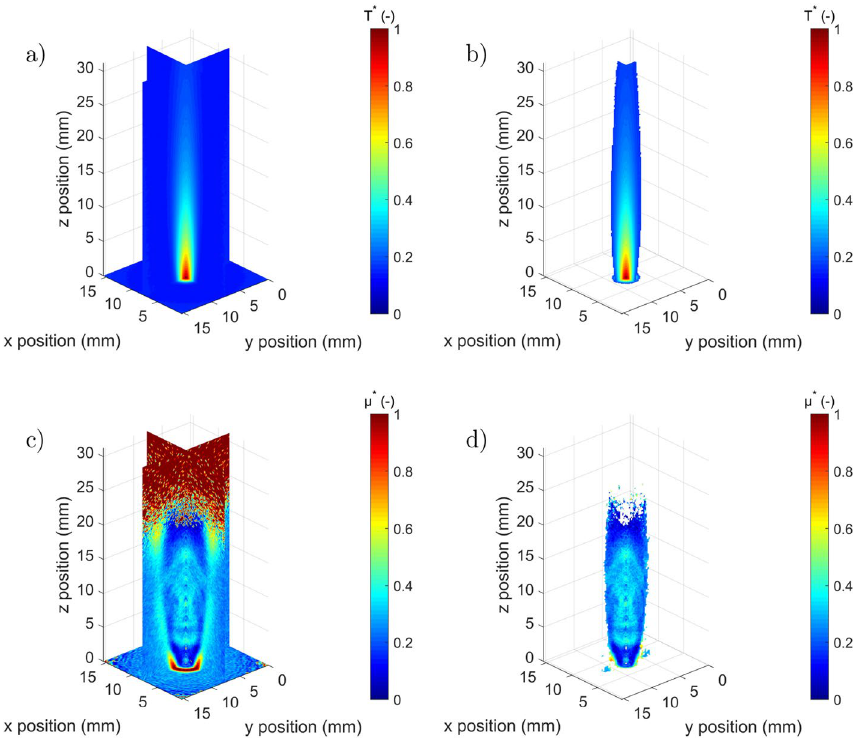
Figure 6. Dimensionless reconstructed three-dimensional maps of the flame: ( a ) 3D proper emission map, ( b ) 3D proper emission map (background removed) and ( c ) 3D absorptivity map at (cid:31) = 4 μm, ( d ) 3D absorptivity map at (cid:31) = 4 μm (background removed). (Created with MATLAB 2020a, https ://mathw orks.com).